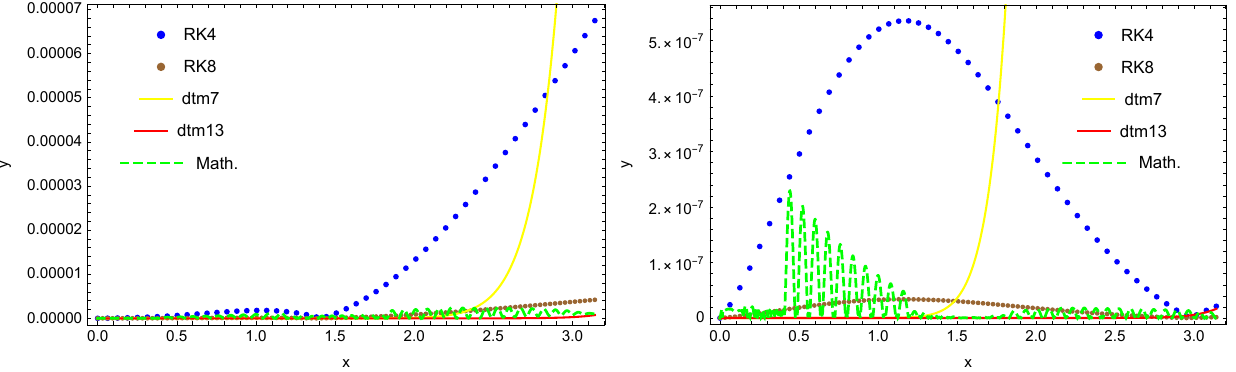
Figure 3. Plot of error ∆ of the approximate